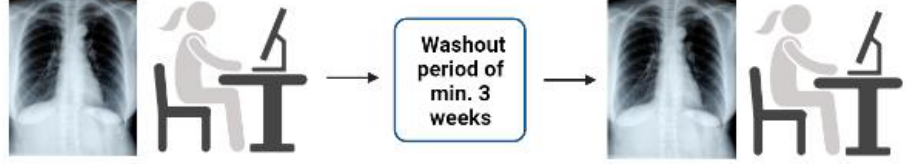
Figure 3. Visualization of the annotation process for each annotator.